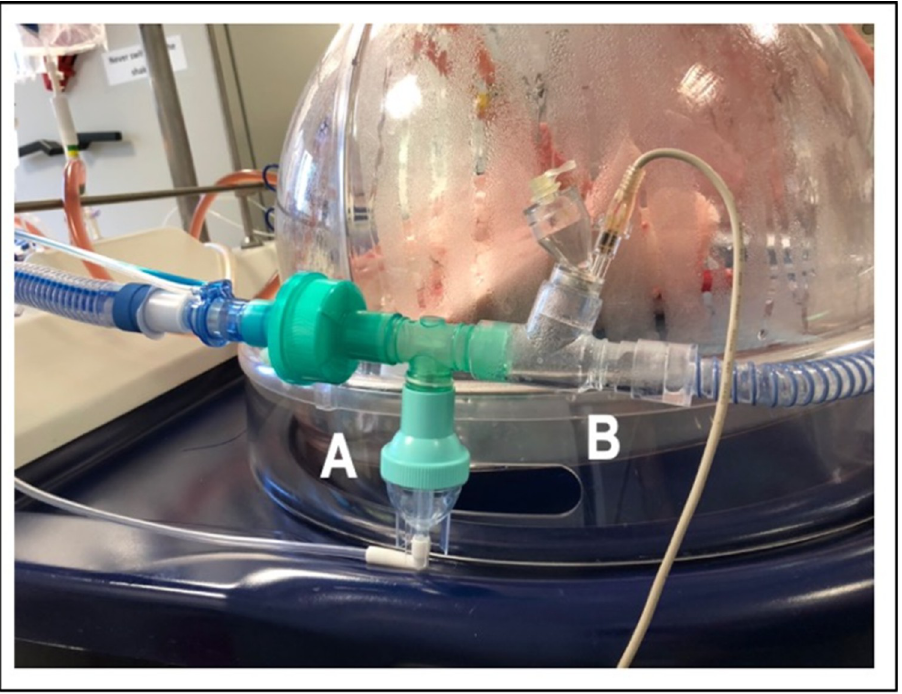
Fig 1. Nebulizer for the bacterial strains (A) and ultrasound nebulizer for the inhalation solution (B).